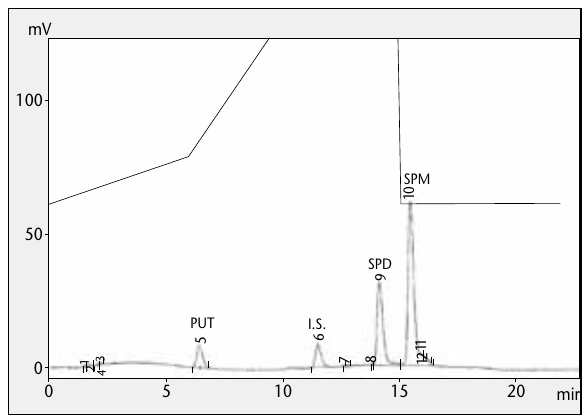
Linear regression analysis of the relation between concentration and peak area of putrescine (PUT), spermidine (SPD) and spermine (SPM) Corr. Substance